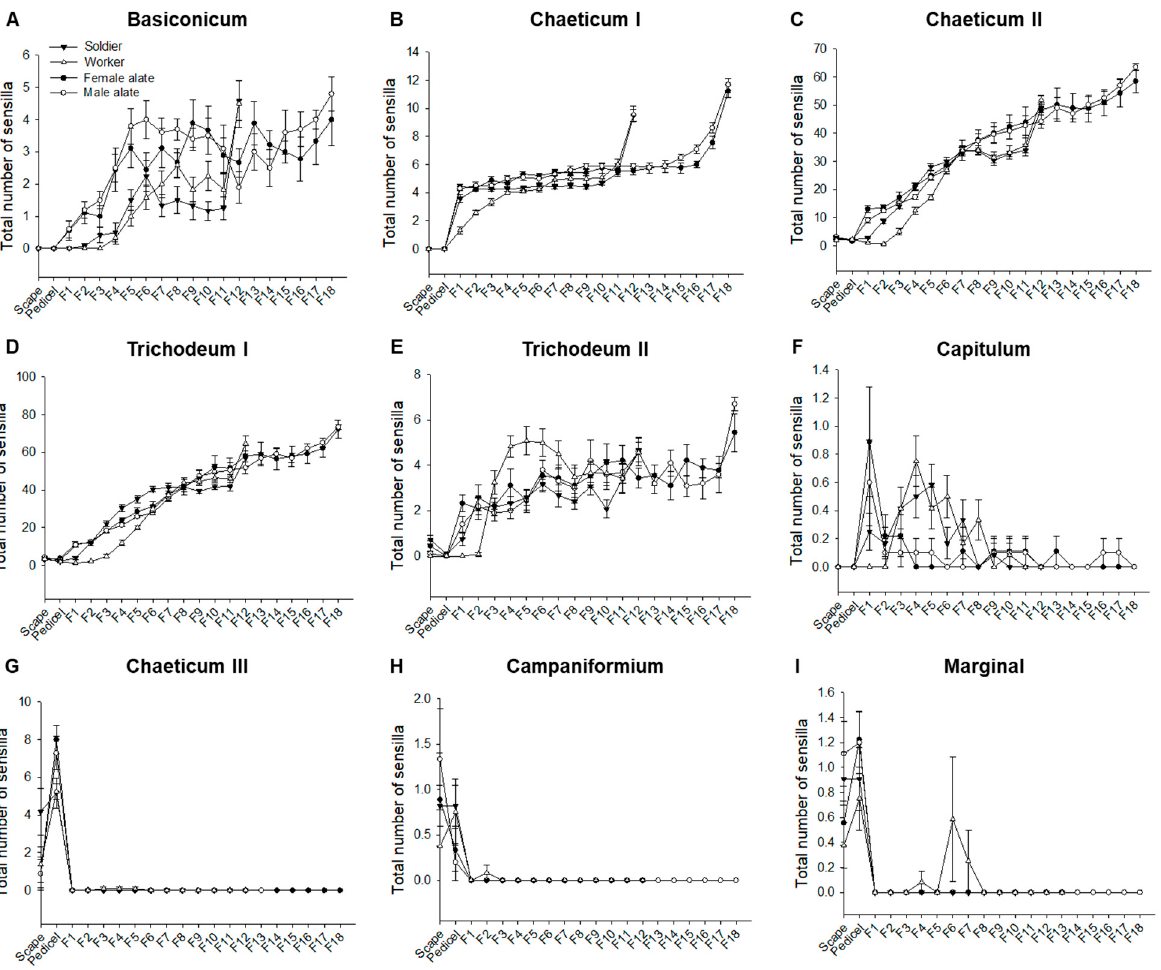
Figure 5. Distribution of nine types of sensilla along the ventral side of the antennae in C. formosanus castes. The numbers of sensilla basiconicum ( A ), chaeticum I ( B ), chaetucum II ( C ), trichodeum I ( D ), trichodeum II ( E ), capitulum ( F ), chaeticum III ( G ), campaniformium ( H ), and marginal ( I ) located on the scape, pedicel, and each flagellomere are shown (mean ± SE, n = 12 for soldiers and workers, n = 9 for female and male alates).